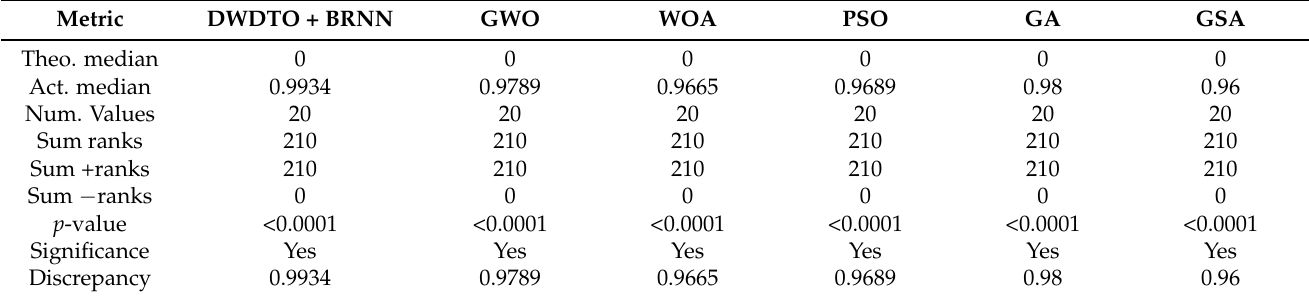
Table 12. Wilcoxon signed-rank test of the achieved results using the second dataset (D2).